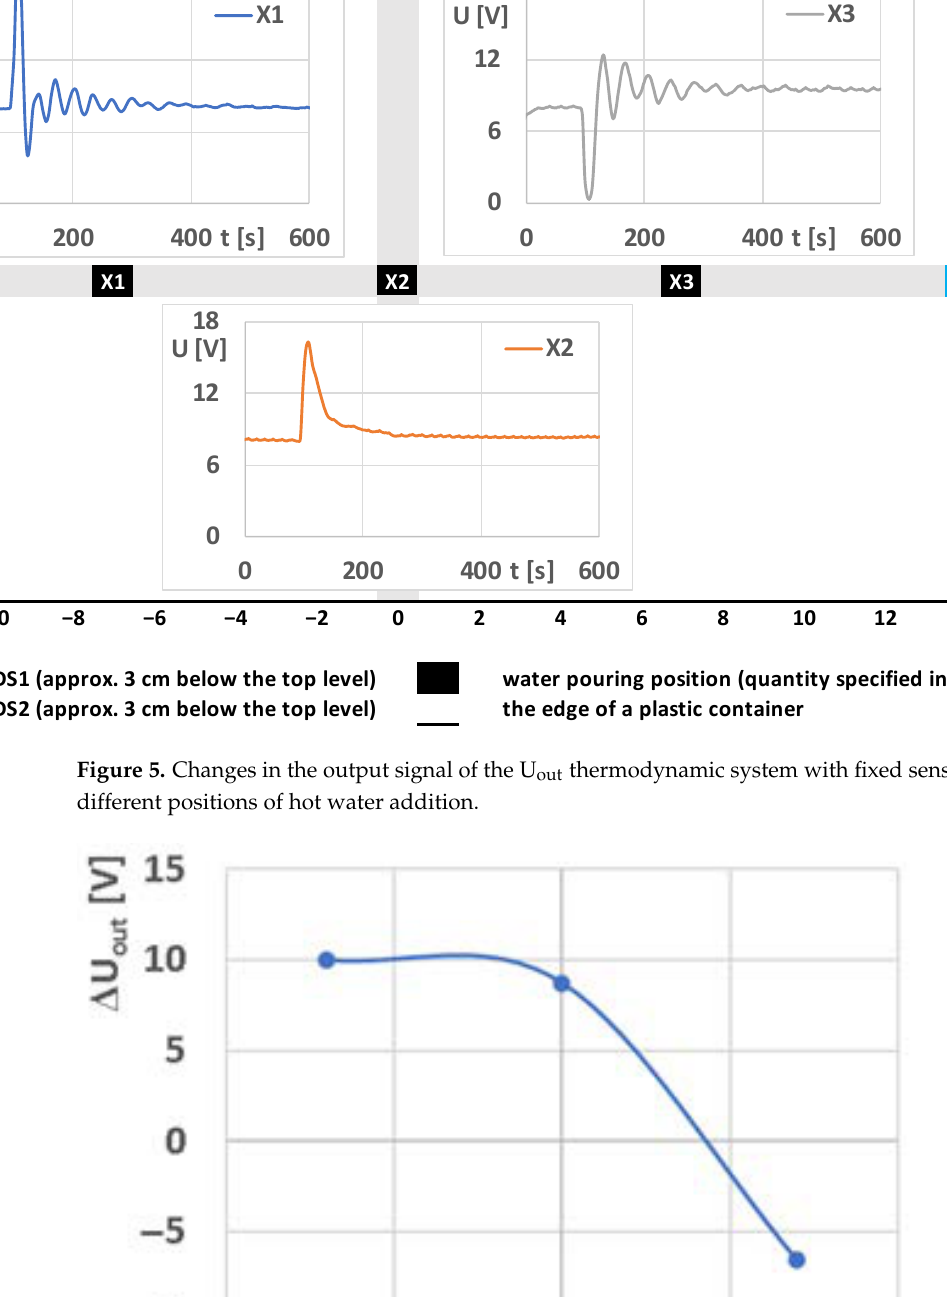
Figure 6. Dependence of the max imum change of the output signal ΔU out (ΔU out = U outMAX − U 0 ) of a thermodynamic system with fixed sensors on the change of hot water addition in the direct direction between the sensors.